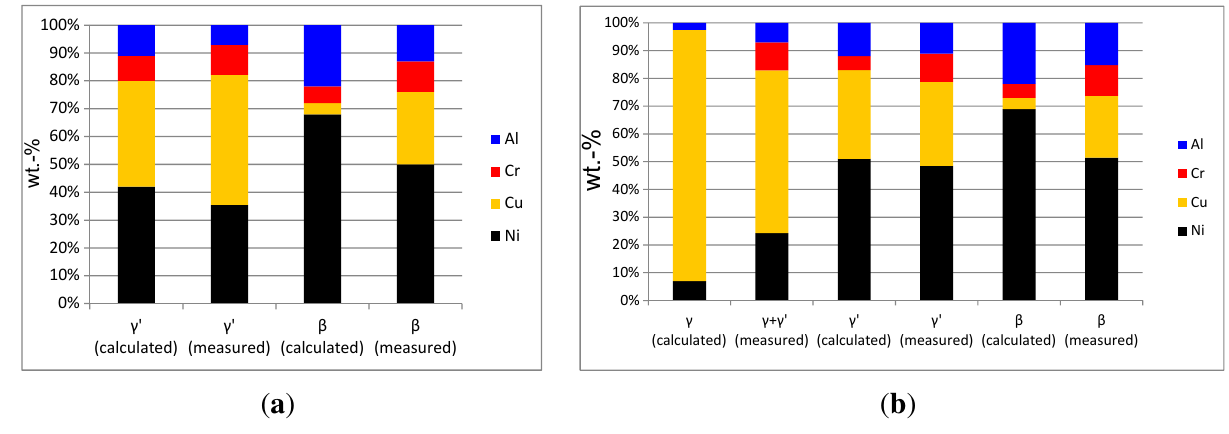
Phase compositions of the alloy Ni-30%Cu-22%Cr-10%Al: measured with EDX and calculated with Thermo-Calc. ( a ) Calculated phase-compositions and measured compositions at 1000 ◦ C; ( b ) calculated phase-compositions and measured compositions at 800 ◦ C. γ and γ ’ in the interdendritic area could not be analyzed separately due to the poor resolution of